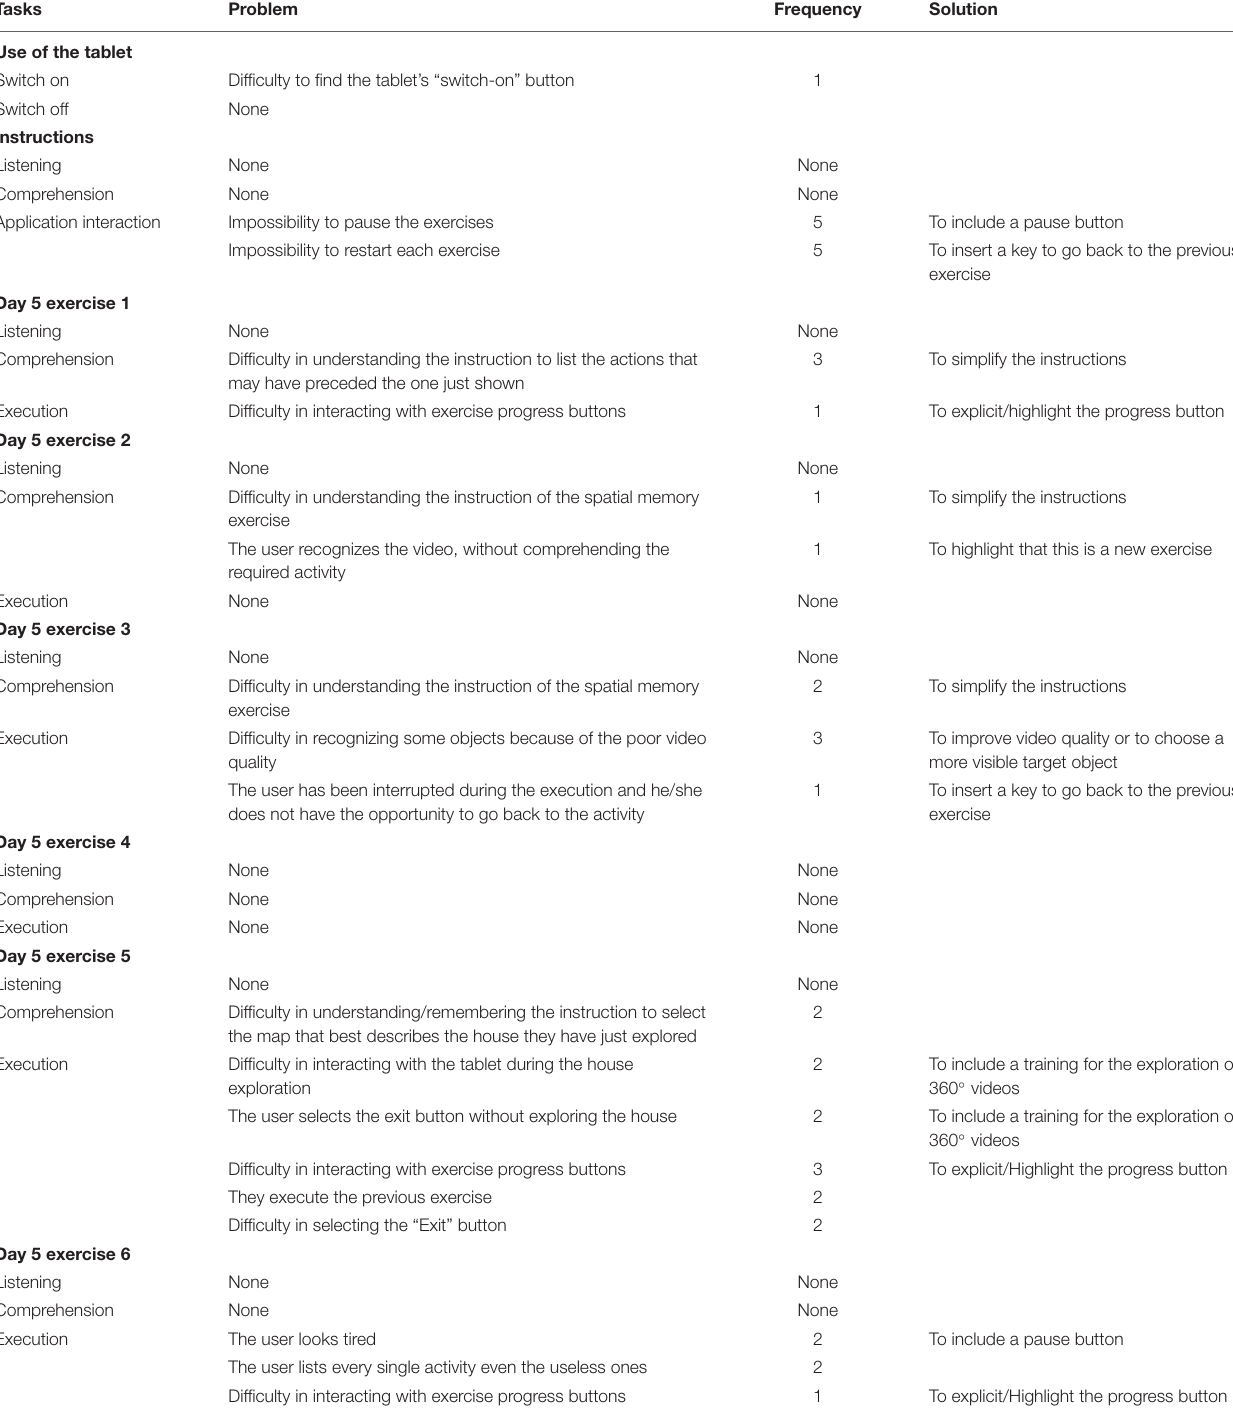
TABLE 2 | Results of the thinking aloud protocol. Tasks Problem Frequency